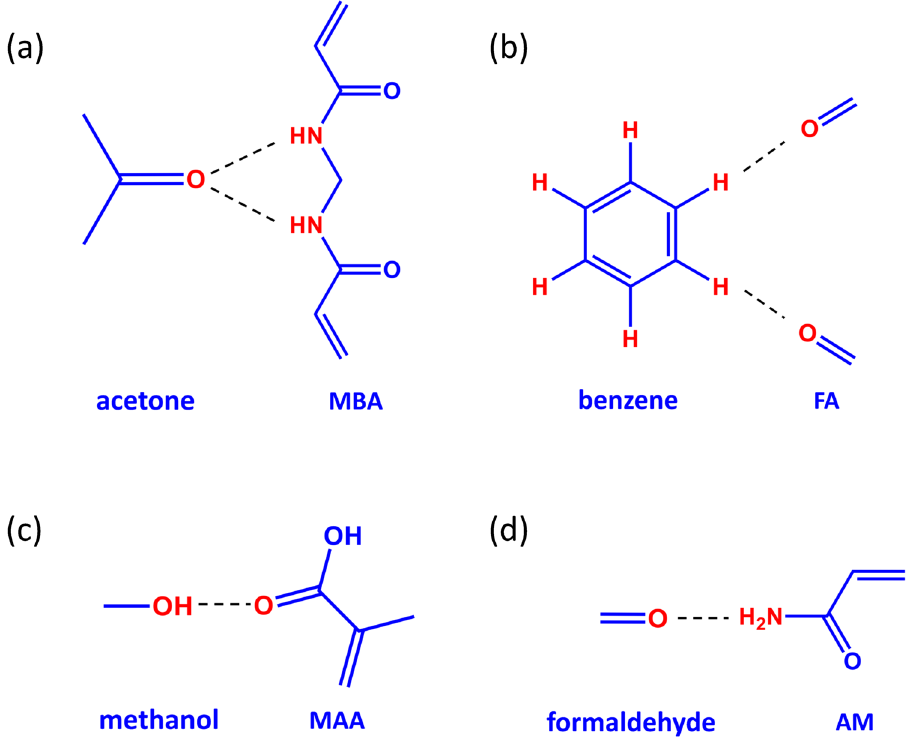
Figure 5. The combinations of the template and functional monomer: ( a ) Acetone and MAA for Mater.a ( b ) Benzene and formaldehyde (FA) for Mater.b ( c ) Methanol and MAA for Mater.m ( d ) Formaldehyde and AM for